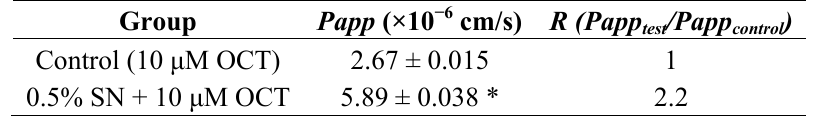
Table 3. The transport ability of SN on OCT (10 uM, A-B) in Caco-2 cells. Control